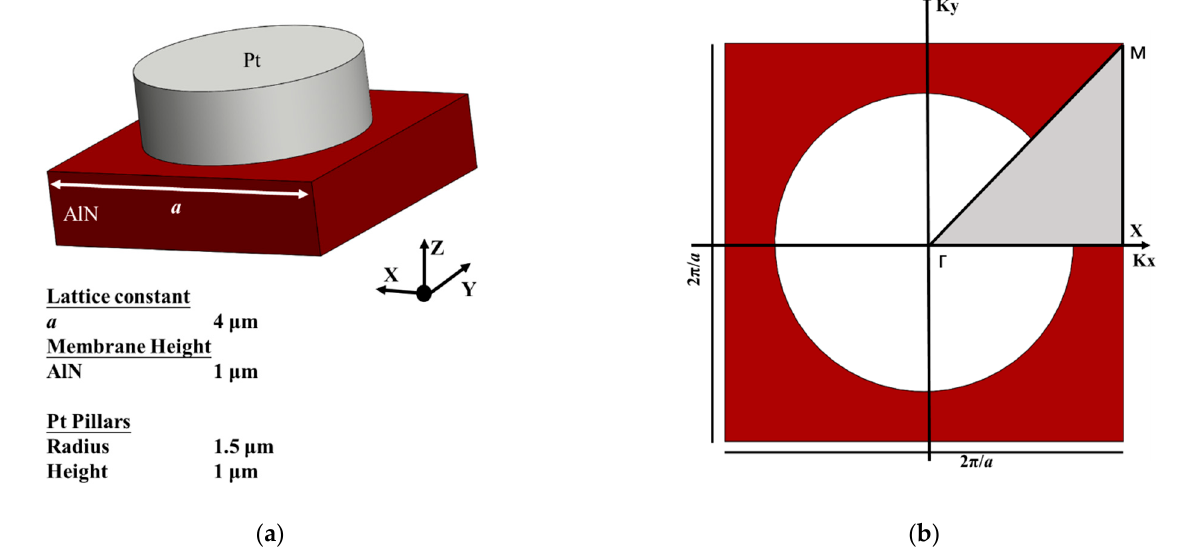
Figure 2. ( a ) Three-dimensional view of the basic unit of the PnC and the geometrical dimension. ( b ) The top view and the irreducible Brillouin zone of the basic unit.